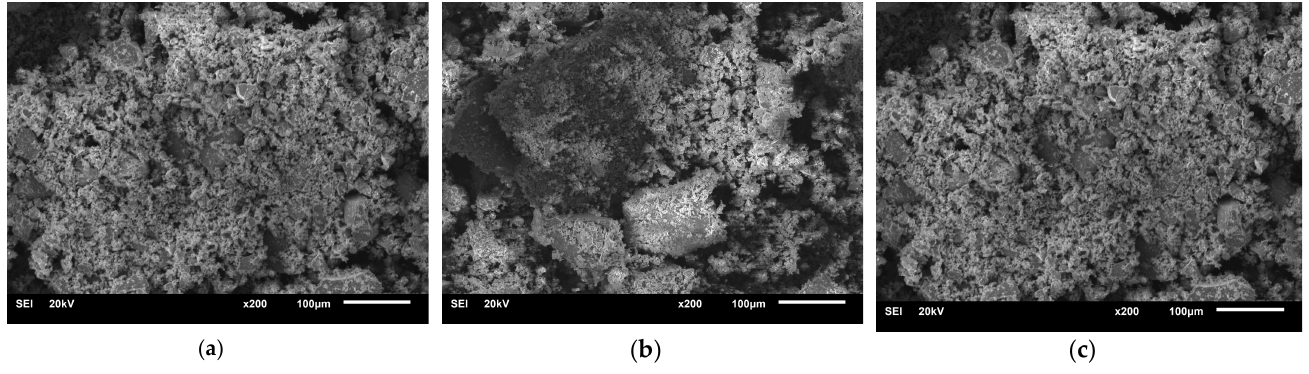
Figure 4. SEM images of powders: ( a ) flake scale, ( b ) powder scale, ( c ) iron oxides. Table 1. Estimated chemical compositions of used materials. Flake scale Powder scale Iron oxides Element Chemical composition (wt.%)